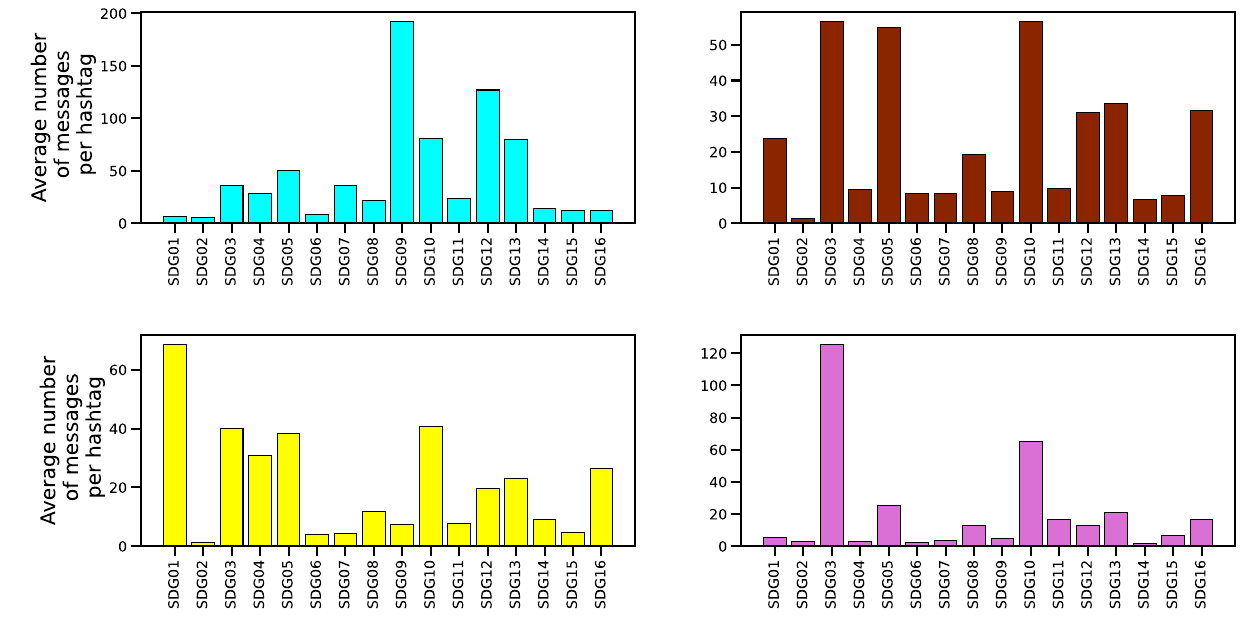
Figure 5. The SDG activity of the four greatest communities in the validated network of Fig. 3. The colors of the different bar charts are the same as in the left panel of Fig. 3. The identification of the various hashtags with the different SDGs is described in detail in the Methods